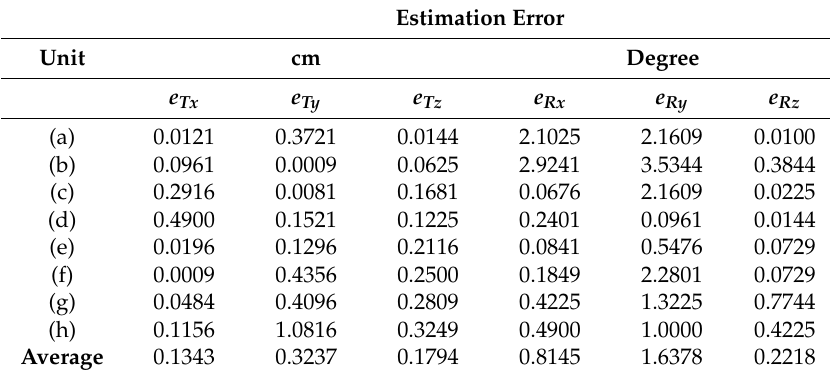
Table 1. Estimation errors of the proposed algorithm shown in Figures 4 and 5.